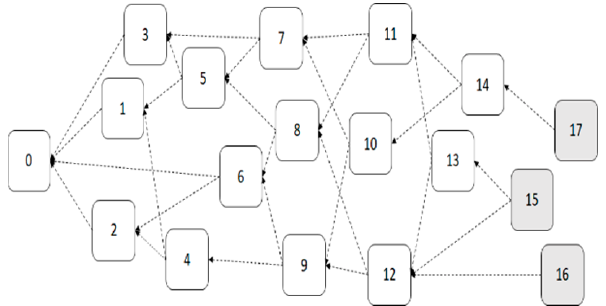
Figure 1. Tangle network .